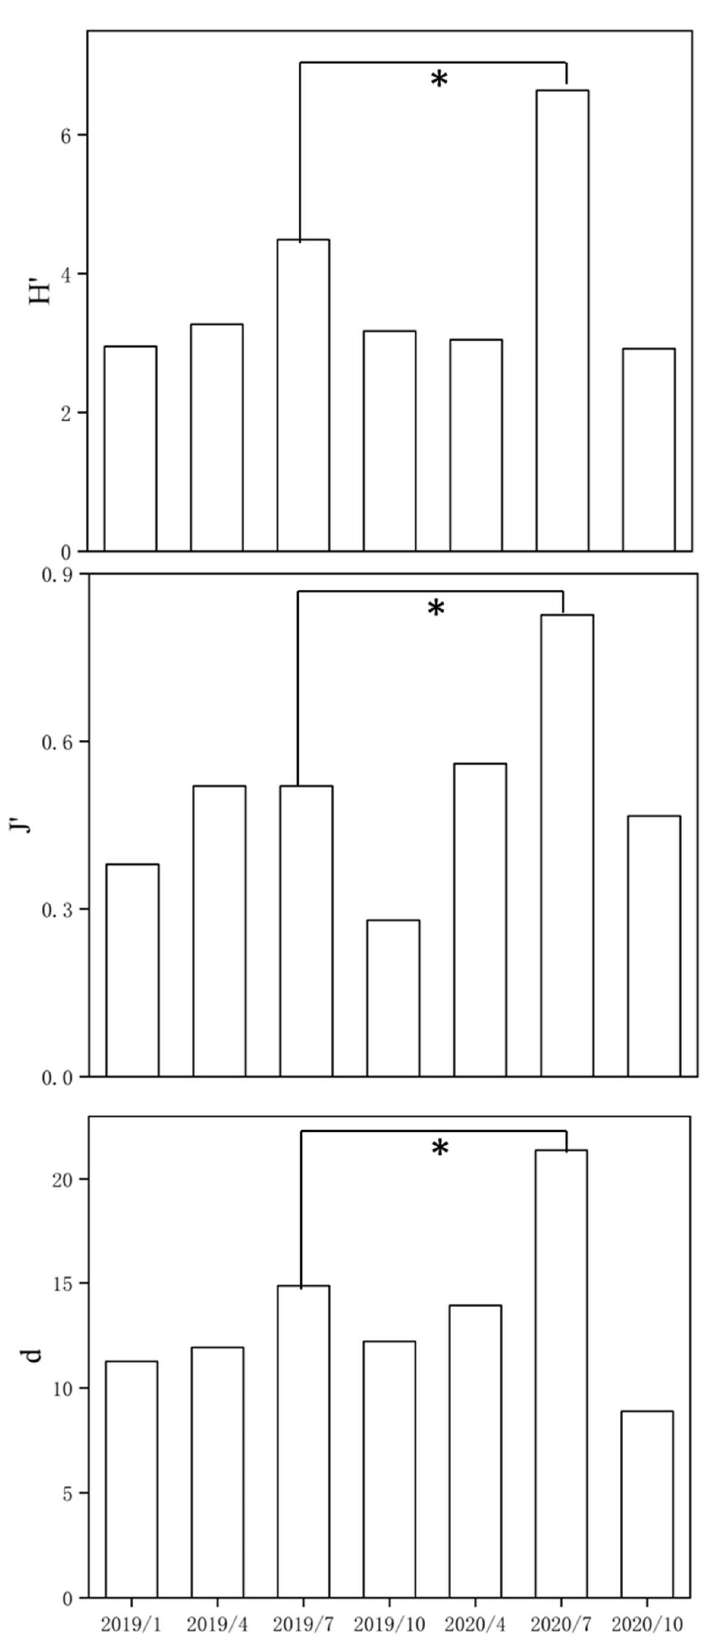
Figure 5. Shannon–Wiener diversity (H’), Pielou evenness (J’), and Marglef richness (d) in the Huayanghe Lakes (* p < 0.05).